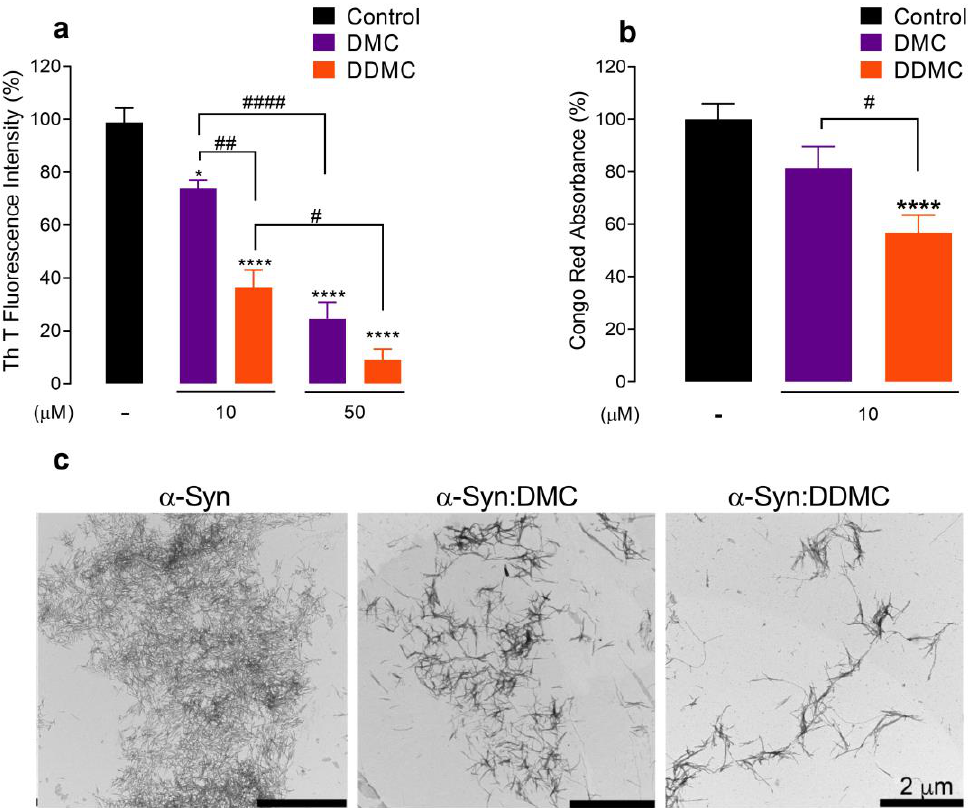
Figure 2. Comparative effect of DMC and DDMC on the inhibition of α-Syn aggregation. ( a ) Effect of DMC and DDMC on α-Syn aggregation as measured by the fluorescence emission intensity of 25 μM ThT in a solution containing 70 μM α-Syn incubated in the presence of 10 or 50 μM DMC or DDMC, after 120 h of incubation. Statistical significance is indicated as: * p = 0.0148; **** p < 0.0001 vs. Control (-); # p = 0.0152 DDMC 10 μM vs. DDMC 50 μM, ## p= 0.0025 DMC 10 μM vs. DDMC 10 μM, #### p < 0.0001 DMC 10 μM vs. DMC 50 μM. ( b ) Absorbance of 20 µM Congo red in a solution containing 70 μM α-Syn incubated in the presence or absence of 10 µM DMC or DDMC. Statistical significance is indicated as: **** p < 0.0001 vs. Control (-); # p= 0.025 DMC 10 μM vs. DDMC 10 μM. Values represent the mean ± SEM ( n = 5), and statistical analyses were performed as described in Materials and Methods. ( c ) Transmission electron microscopy (TEM) of α-Syn samples incubated for 120 h in the presence of 10 μM DMC or DDMC.